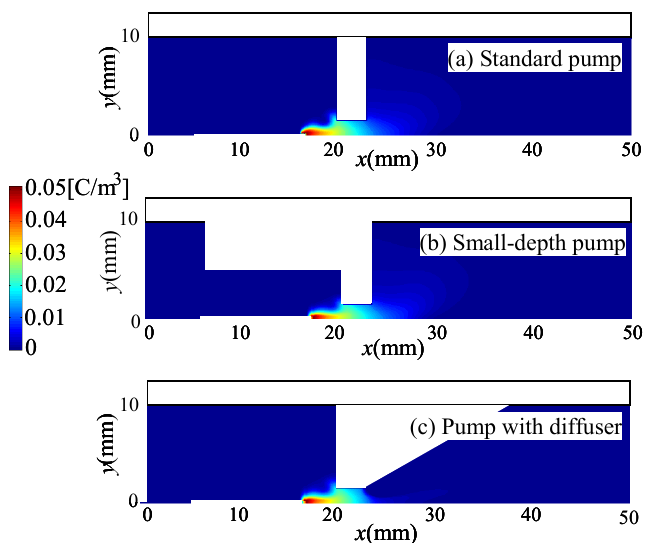
Fig.13 Effect of pump configuration on charge density distribution (simulation, V =10kV, Q =8cm 3 /s, k =7.10×10 -9 C/(V ･ m 2 ), µ distribution causes a reduction in the pump